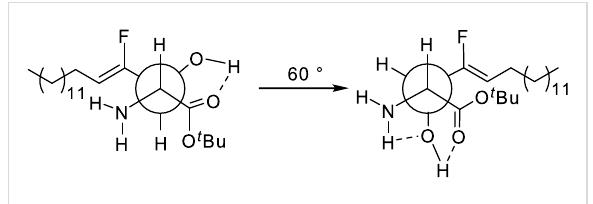
Figure 2: Favorable conformations of the tert -butyl amino acid ester 7 .